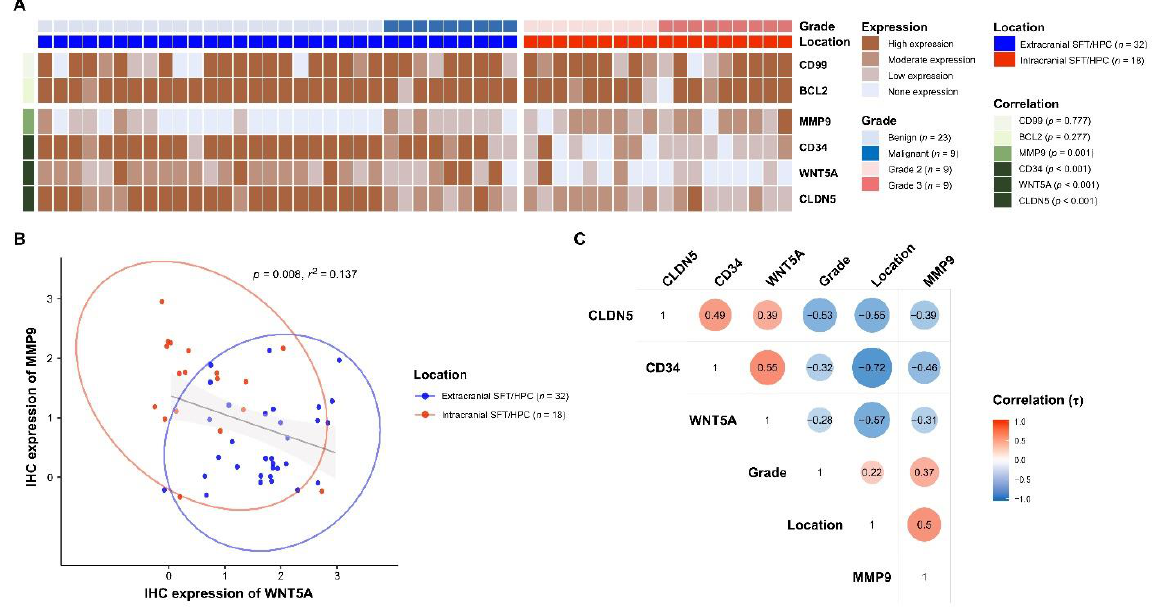
Figure 3. Analysis of IHC staining of SFT/HPC. ( A ) Heatmap of IHC expression of BCL2, CD99, MMP9, CD34, WNT5A, and CLDN5, displayed with grades and locations of SFT/HPCs. p -values are for the correlation between location and IHC expression. ( B ) Linear correlation analysis of IHC expression of MMP9 and WNT5A. Circles represent groupings according to SFT/HPC location. ( C ) Correlogram of IHC expression of CLDN5, CD34, WNT5A, and MMP9 according to location and grade of SFT/HPC. Red circles indicate a positive correlation between the paired variables and blue circles a negative correlation. The intracranial location was coded as a positive value, and the extracranial location as a negative value.